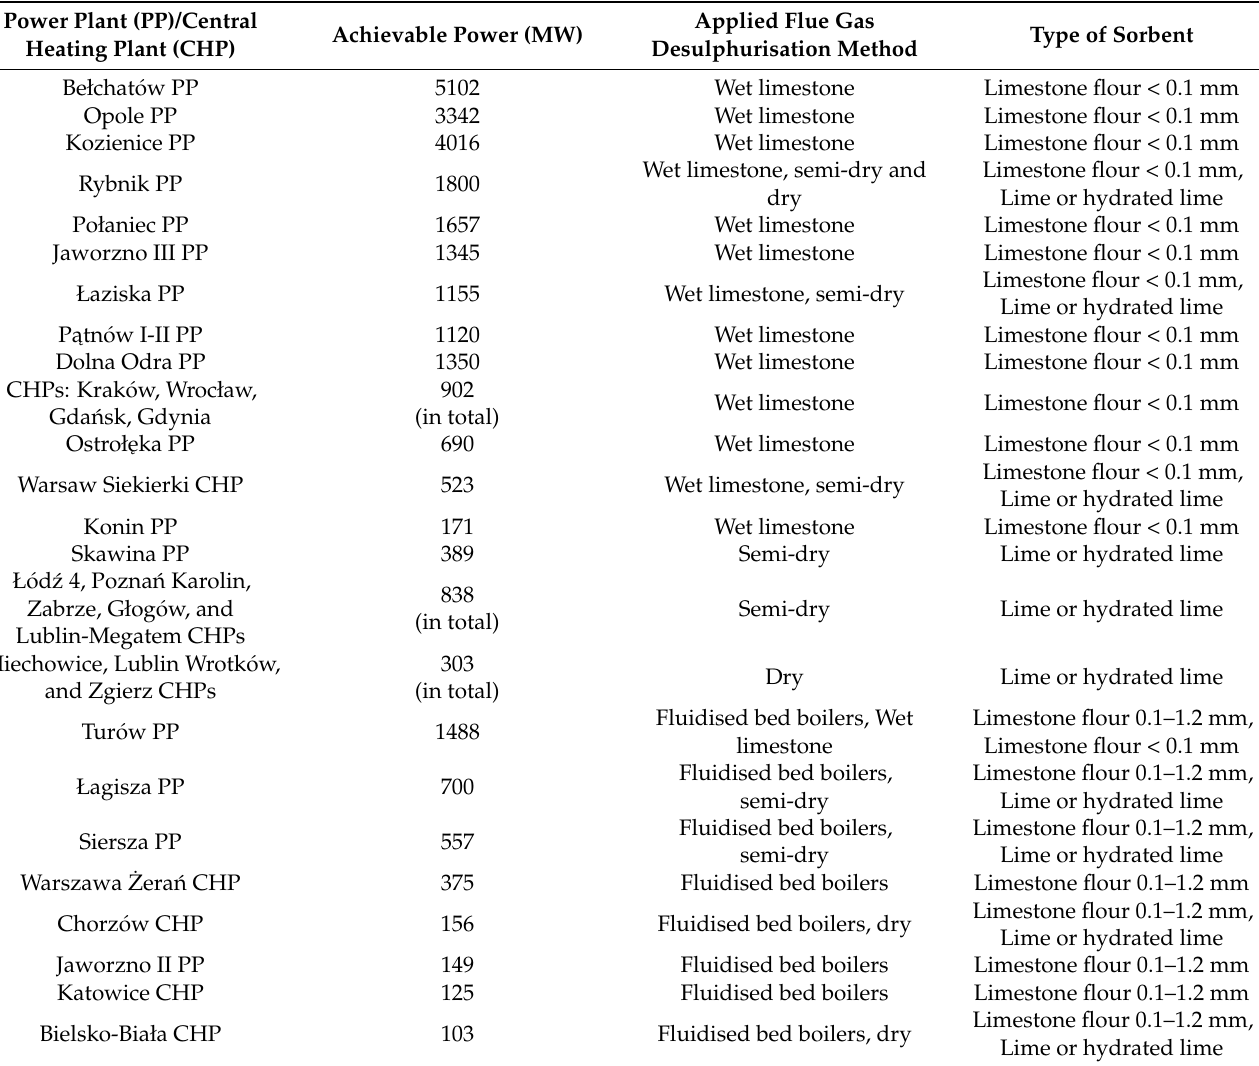
Table 3. The main flue gas desulphurisation installations in the Polish power plants and central heating plants (as of 29 November 2019) [41,42], surveyed sorbent user